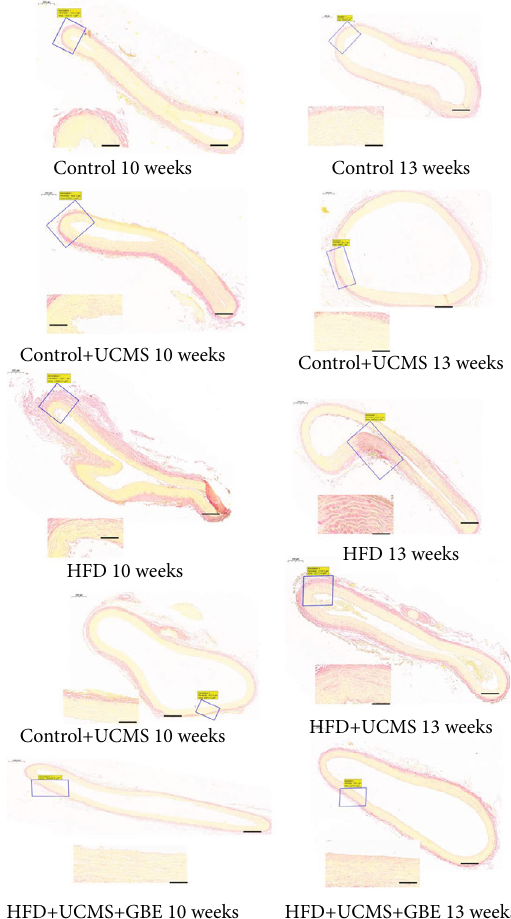
Figure 3: Picrosirius red staining of vessels. Picrosirius red staining of aorta ascendens sections in di ff erent groups, the red color indicates collagen fi bers; the scale bar: 2000 μ m for the entire section and 200 μ m for the local